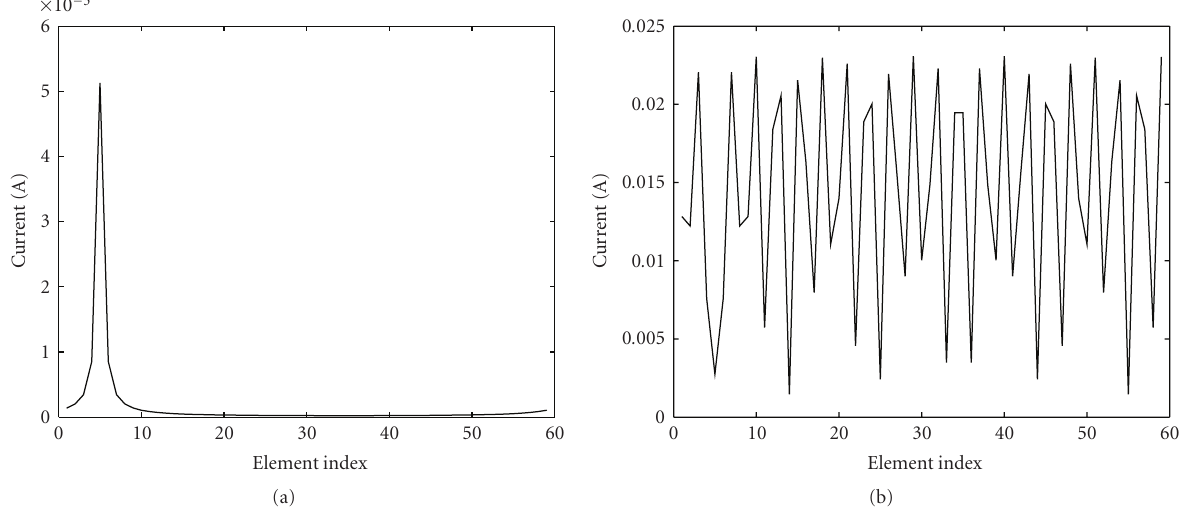
Figure 4: Magnitude of port currents obtained for the array configurations referred to in the previous section, when element 5 only is excited. Discrete-ASM solution obtained for N = 59. (a) without eigenmodes; (b) with eigenmodes.